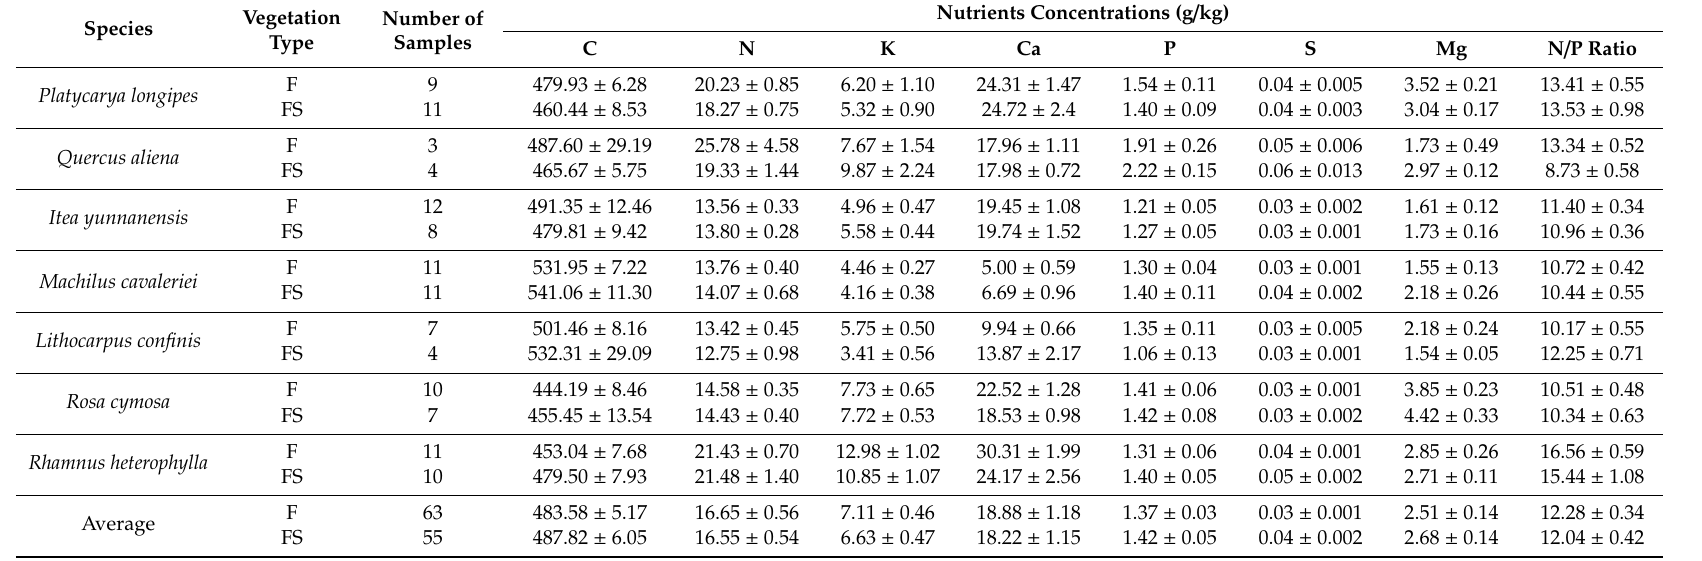
Table 4. Leaf nutrient concentrations of typical species in the karst study area, southwest China. F (abor forest); FS (shrub–arbor